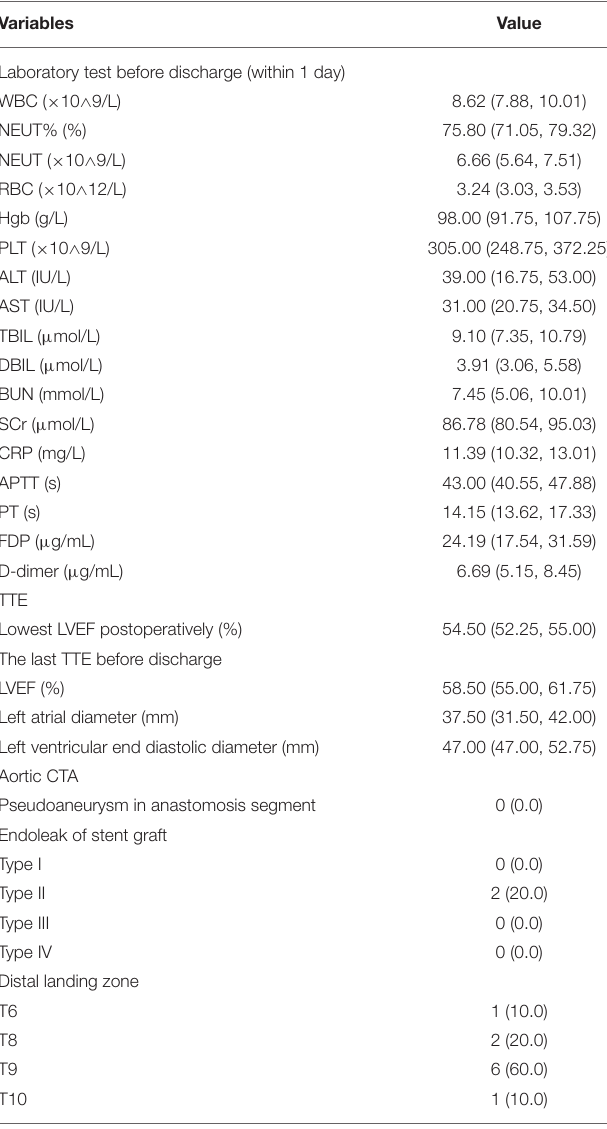
TABLE 4 | Postoperative